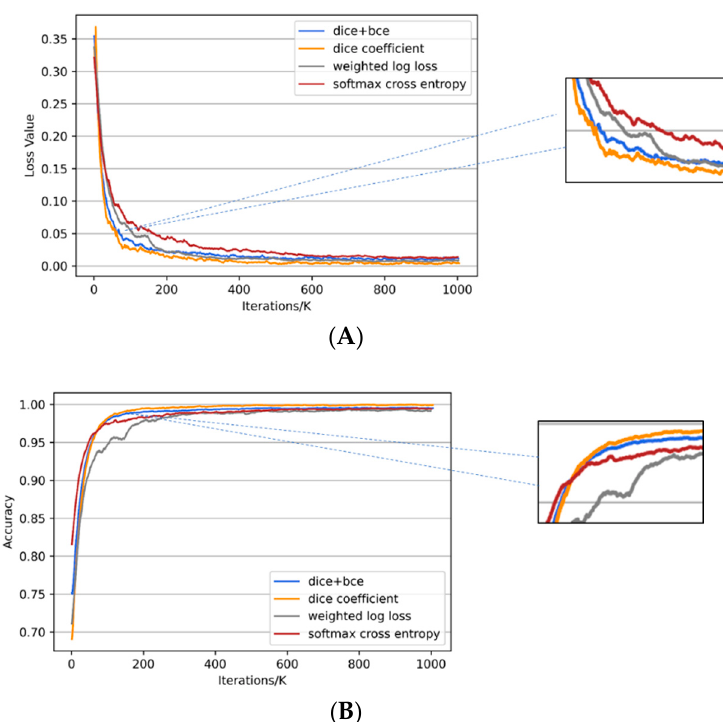
Figure 9. Progression of loss values ( A ) and training accuracy ( B ) for four loss functions used with Nested SE-Deeplab during training. The loss functions are softmax cross entropy (softmax), weighted log loss, dice coefficient (dice), and dice coefficient added with binary cross entropy (bce).